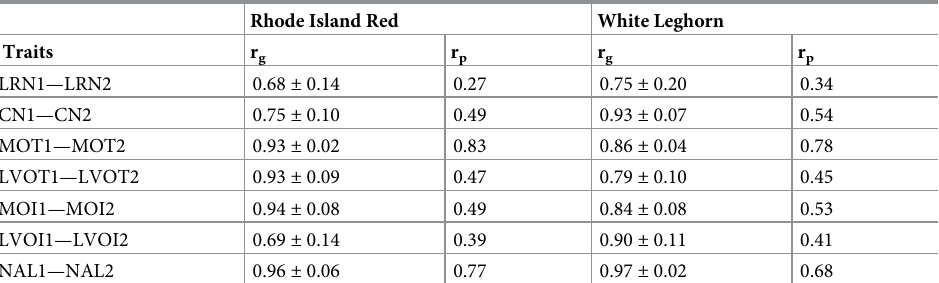
LRN, laying rate in the nests; CN, clutch number; MOT, mean oviposition time; LVOT, logarithm of the variance of oviposition time; MOI, mean oviposition interval; LVOI, logarithm of the variance of oviposition interval; NAL, nest acceptance for laying. The number after abbreviations indicates the breeding period: 1 for the peak and 2 for the middle of